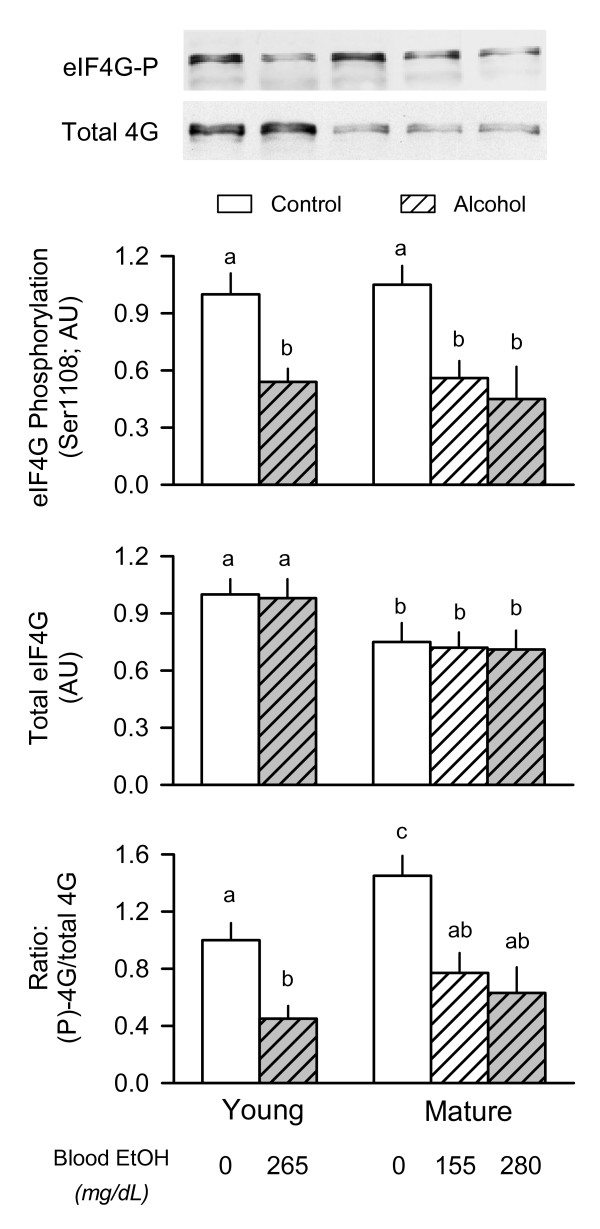
Effect of acute alcohol intoxication on the total amount and phosphorylation of eIF4G in skeletal muscle from young and mature rats. Groups are the same as described in Figure 1. Gastrocnemius was collected 2.5 h after administration of alcohol or saline (control). Inset at top: representative Western blots of phosphorylated and total eIF4G. Top and middle graphs: densitometric analysis of immunoblots of Ser1108-phosphorylated eIF4G and total eIF4G, respectively, in muscle. Bottom graph: ratio of phosphorylated (P) to total eIF4G in muscle. Values (means ± SEM) are expressed relative to the young saline-treated control group. Sample size was 10, 10, 6, 7, 9, and 9 for the six groups, respectively. Values with different letters are significantly different from each other, P < 0.05. Values which share a common letter are not statistically different.